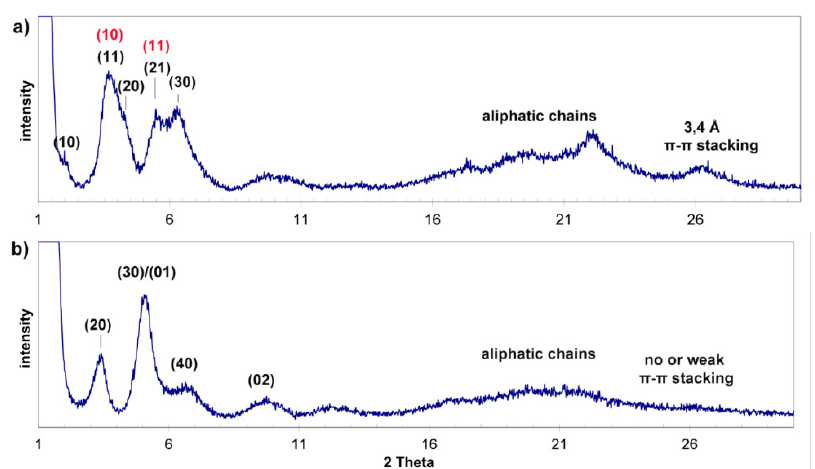
Figure 6. X-ray diffraction patterns of: ( a ) Xerogel of triphenylene 5 from methanol (in red, reflections of the tetragonal array overlapped with the (11) and (21) reflections of the hexagonal lattice) and ( b ) xerogel of triphenylene 6 from n -hexane.